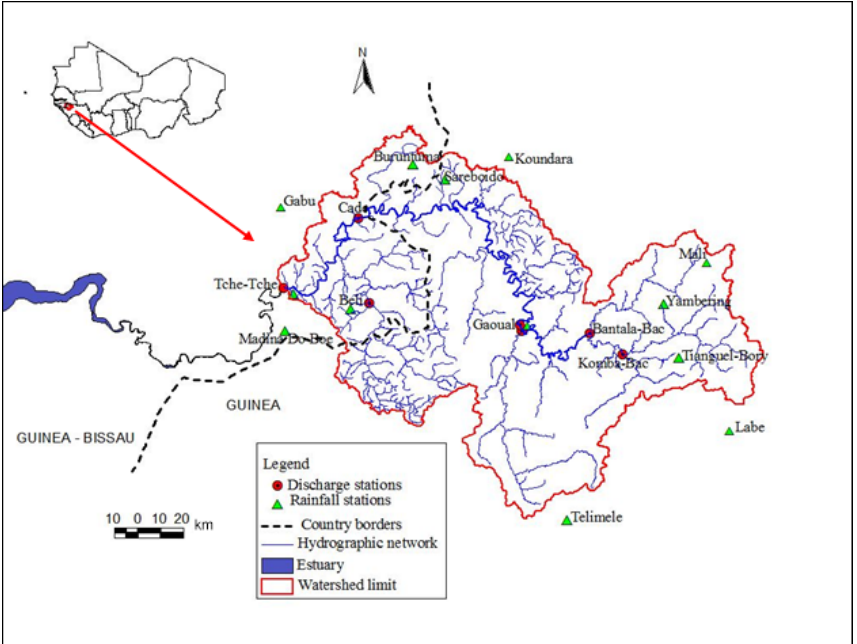
Figure 1. Location of the Koliba/Corubal River watershed in West Africa and spatial distribution of rainfall and hydrometric networks.